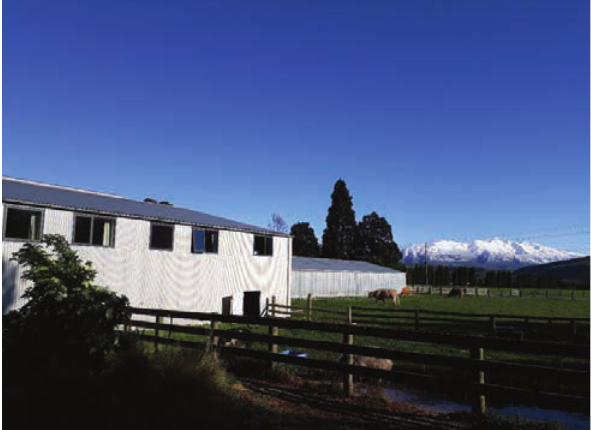
Figure 6: Waitaki woolshed conversion (rear view), Waitaki District, South Island, New Zealand. Image provided by Author (Mike